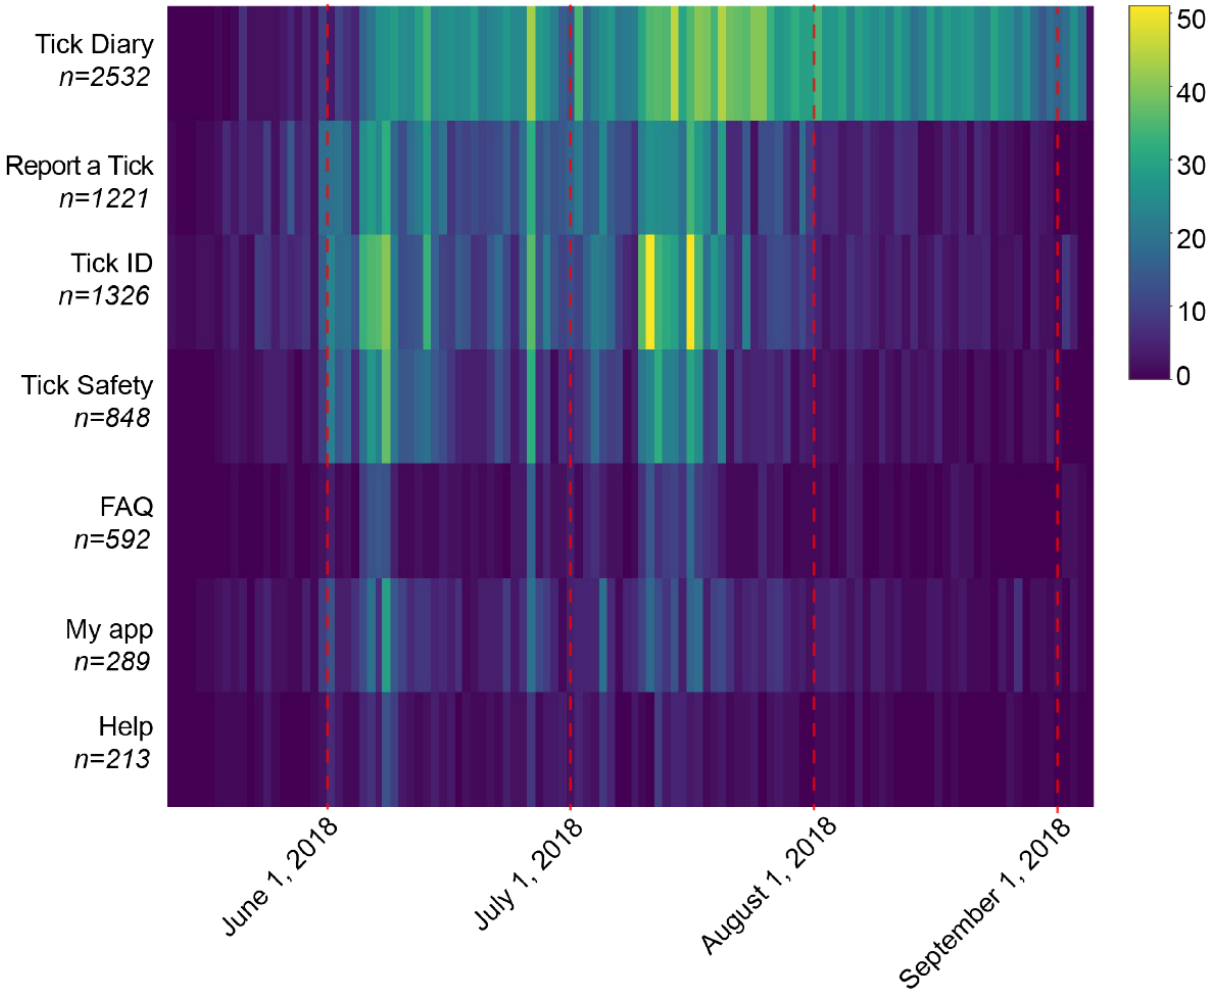
Figure 7. Heatmap of the independent screen views (every 5 min) per functionality, for all users between May and September 2018. For each day and functionality, the lighter color (see color scale) indicates a higher number of independent screen views. The dashed red lines indicate the first day of each month for